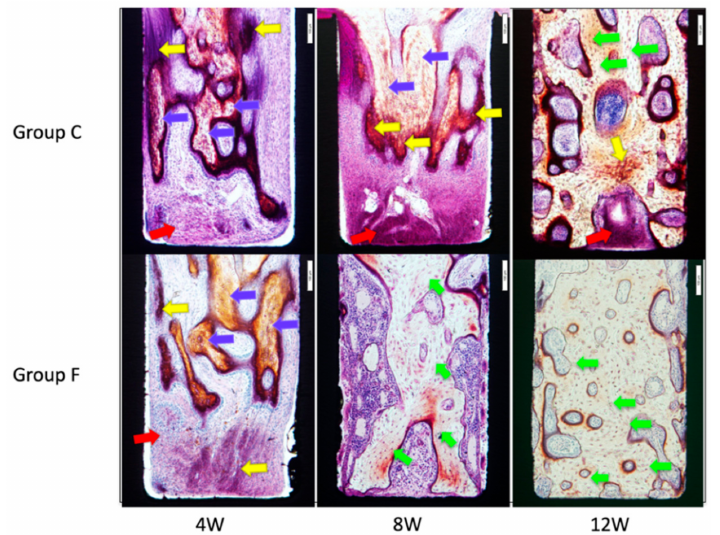
Figure 5. Microscopic images of inner surfaces of the slits under natural light. Yellow arrows indicate fibrous osteoids, blue arrows are fibrous bones, red arrows are fibroblasts, and greenish-yellow arrows indicate lamellar